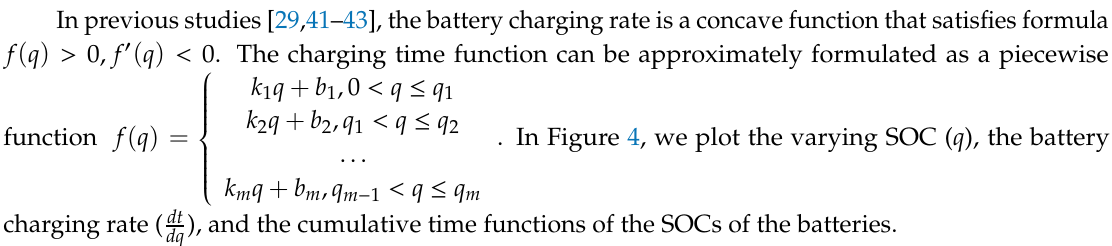
Figure 3. Operation process in the SSCS. Abbreviation: IPC—information processing center.